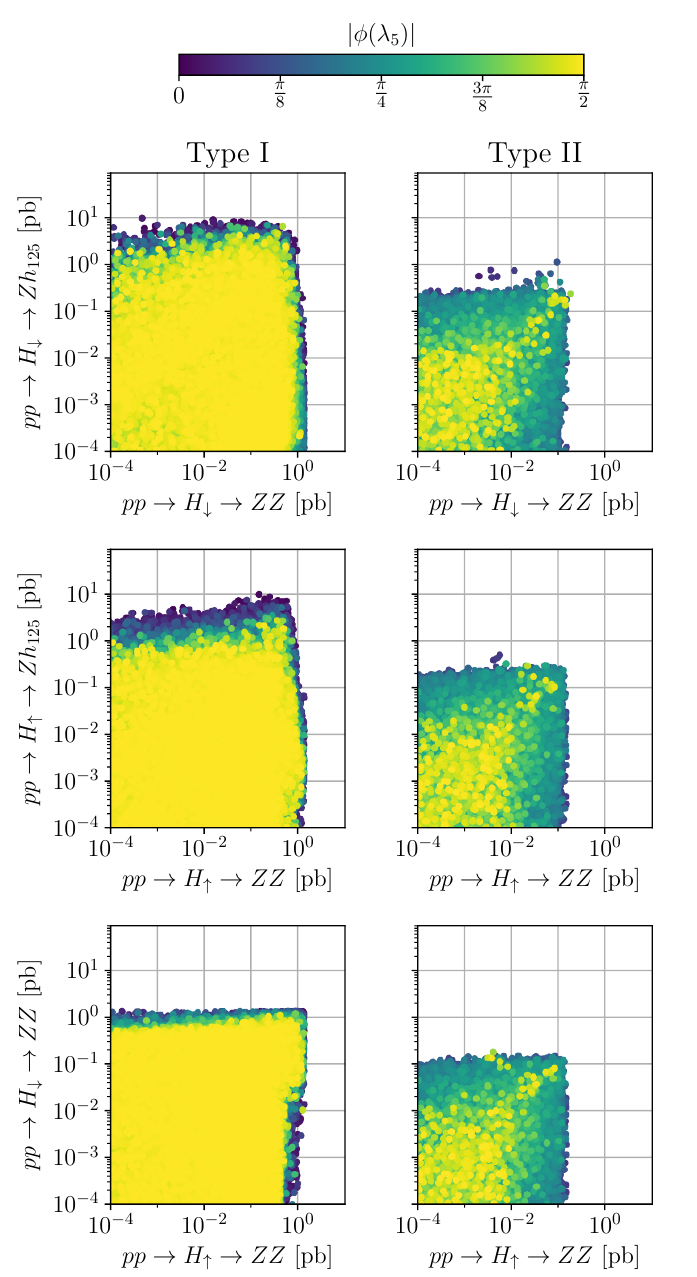
Figure 9 . Set of CP-violating processes as a function of the CP-violation phase colour code) for Type I (left column) and Type II (right column). In the (cid:12)rst row we show pp H Zh 125 against pp H ZZ , in the second row we have pp ! # ! # ! pp H ZZ and in the third row we plot pp H ZZ against pp ! ! " ! # ! the yellow points are superimposed on the darker points - there are dark points underneath the yellow points.